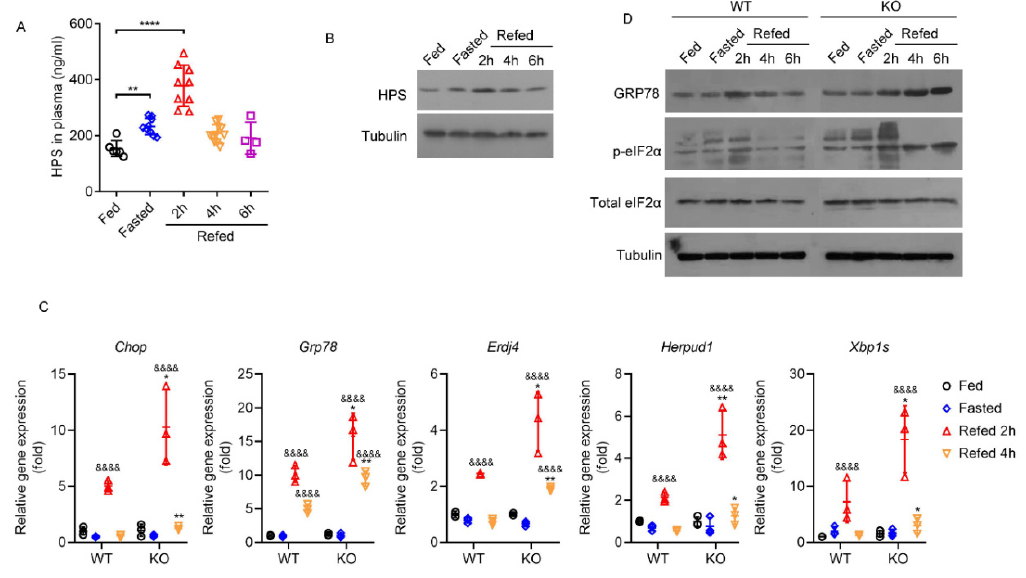
Figure 4. HPS deficiency exacerbates fasting/refeeding induced Hepatic ER stress in mice. For panels ( A , B ), eight-week-old WT mice were starved for 16 h, followed by refeeding for the number of hours indicated ( n = 3–12). ( A ) ELISA was performed to measure plasma HPS levels. Data are expressed as mean ± SD of all samples for each group. The significant difference between the mean relative values of the two groups was analyzed by Student t test (** p < 0.01, **** p < 0.0001). ( B ) The liver protein samples of three mice in each group were pooled for immunoblotting analysis to detect the levels of HPS. For panels ( C , D ), 8-week-old WT and HPS-KO mice were starved for 16 h, followed by refeeding for the number of hours indicated ( n = 3). ( C ) Q-PCR analysis of ER stress markers in mice liver. Data are expressed as mean ± SD of all samples for each group. The significant